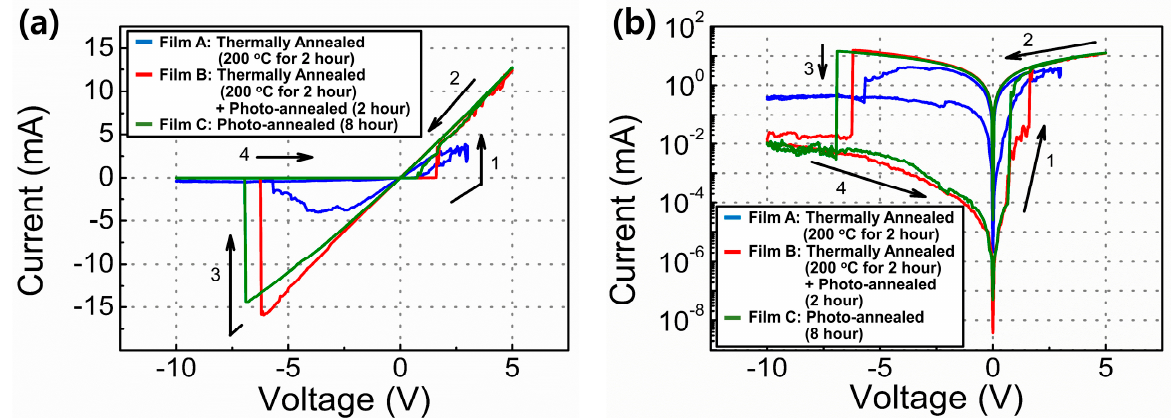
Figure 6. Representative I–V curves of ITO/Y 2 O 3 /Ag RRAM devices. The arrows and numbers indicate the voltage bias directions. ( a ) Linear scale and ( b ) log scale.